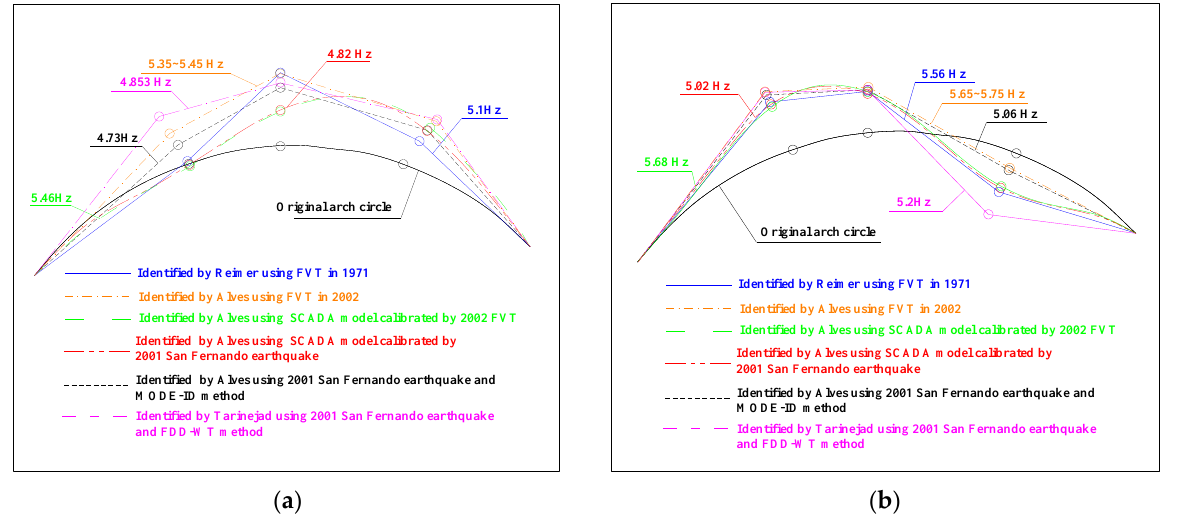
Figure 9. Comparison of the system identification results of the vibration modes in the literature: ( a ) the first-order symmetric vibration mode; ( b ) the first-order anti-symmetric vibration